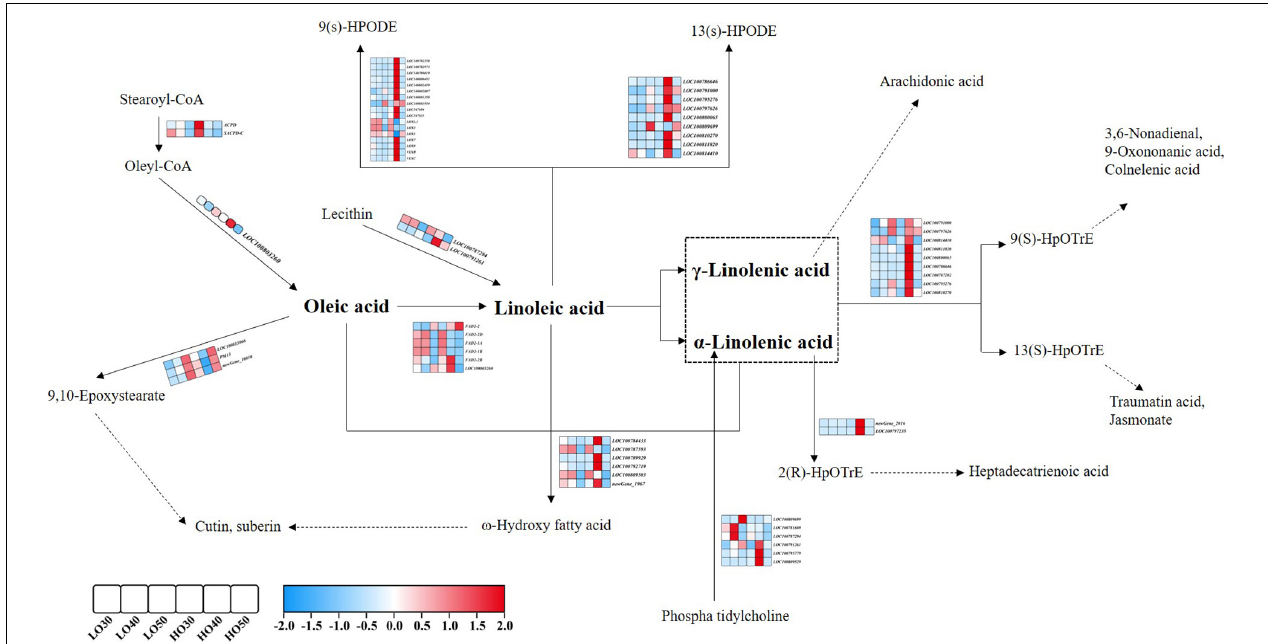
FIGURE 4 | Overview of the distribution of DEGs in the metabolic pathway of oleic and linoleic acids during soybean seed development. Gene IDs or names and expression patterns are indicated. The expression pattern of each gene is shown by 6 grids, which representing the relative log2 (expression ratio) at LO 30, LO 40, LO 50, HO 30, HO 40, and HO 50,